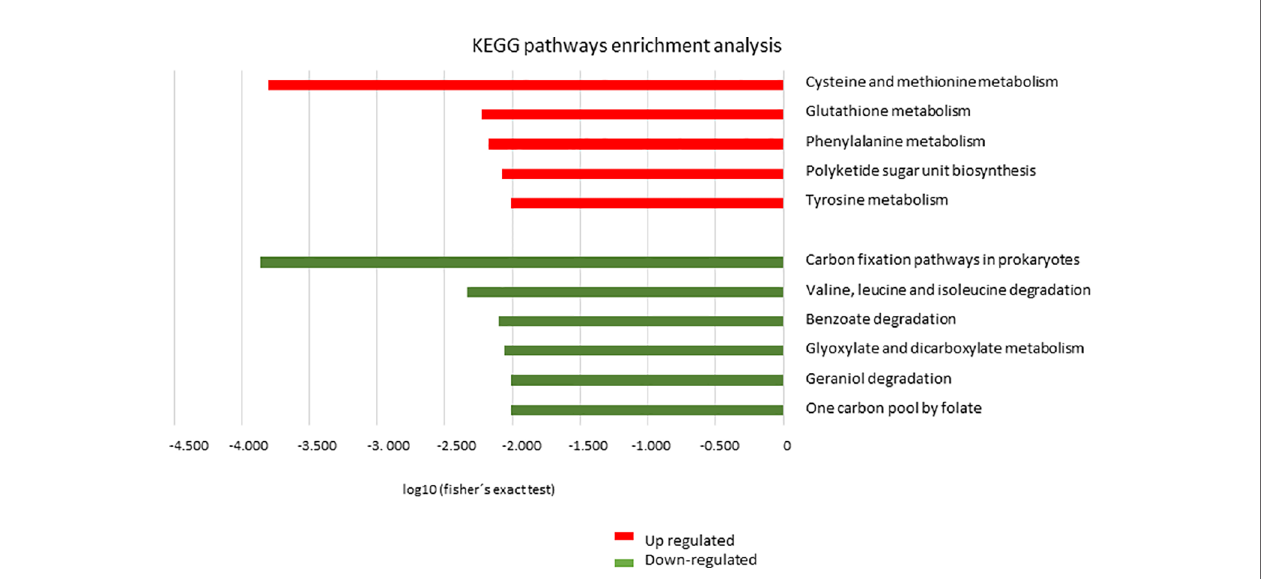
FIGURE 4 | Analysis of enrichment of metabolic pathways by KEGG. Distribution of proteins based on metabolic pathways in L. braziliensis from the atypical lesions group (LbAL) compared to the typical lesions group (LbTL). In red, metabolic pathways enriched in the upregulated protein group; in green, metabolic pathways enriched in the downregulated protein group. Terms overrepresented by P < 0.01 in Fisher ’ s exact